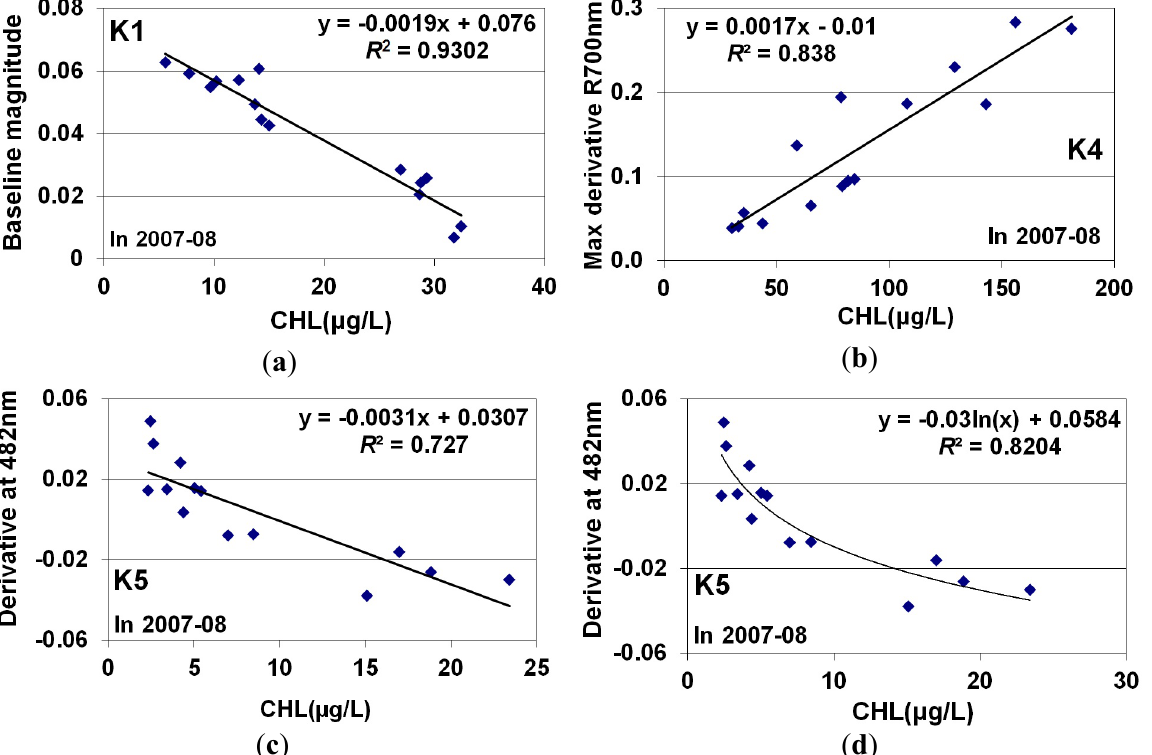
Figure 6. Received correlations between various algorithms and biomass concentration for kettle holes K1, K4 and K5. Note scale, axes and algorithms